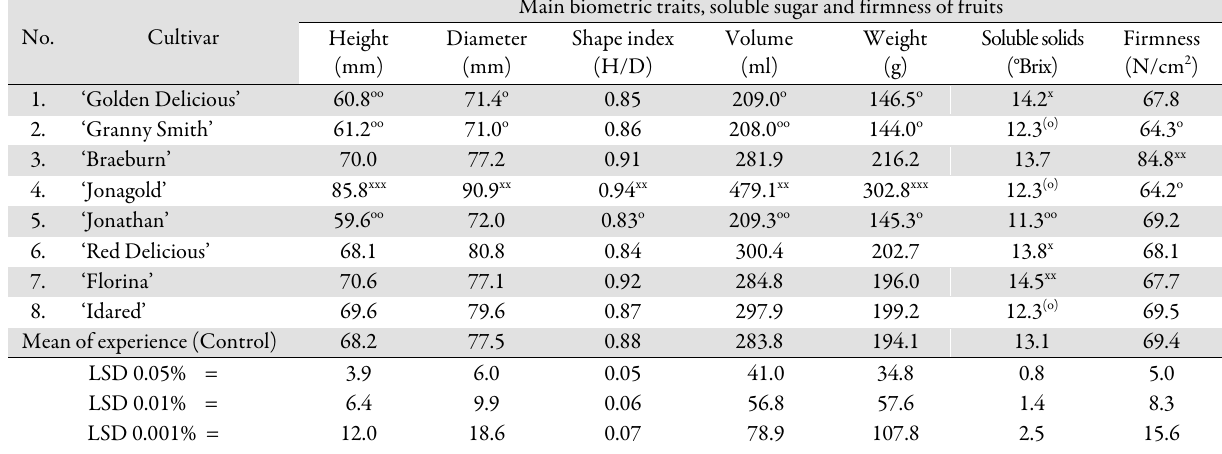
Table 1. Specific determinations data for apple fruit prior tasting